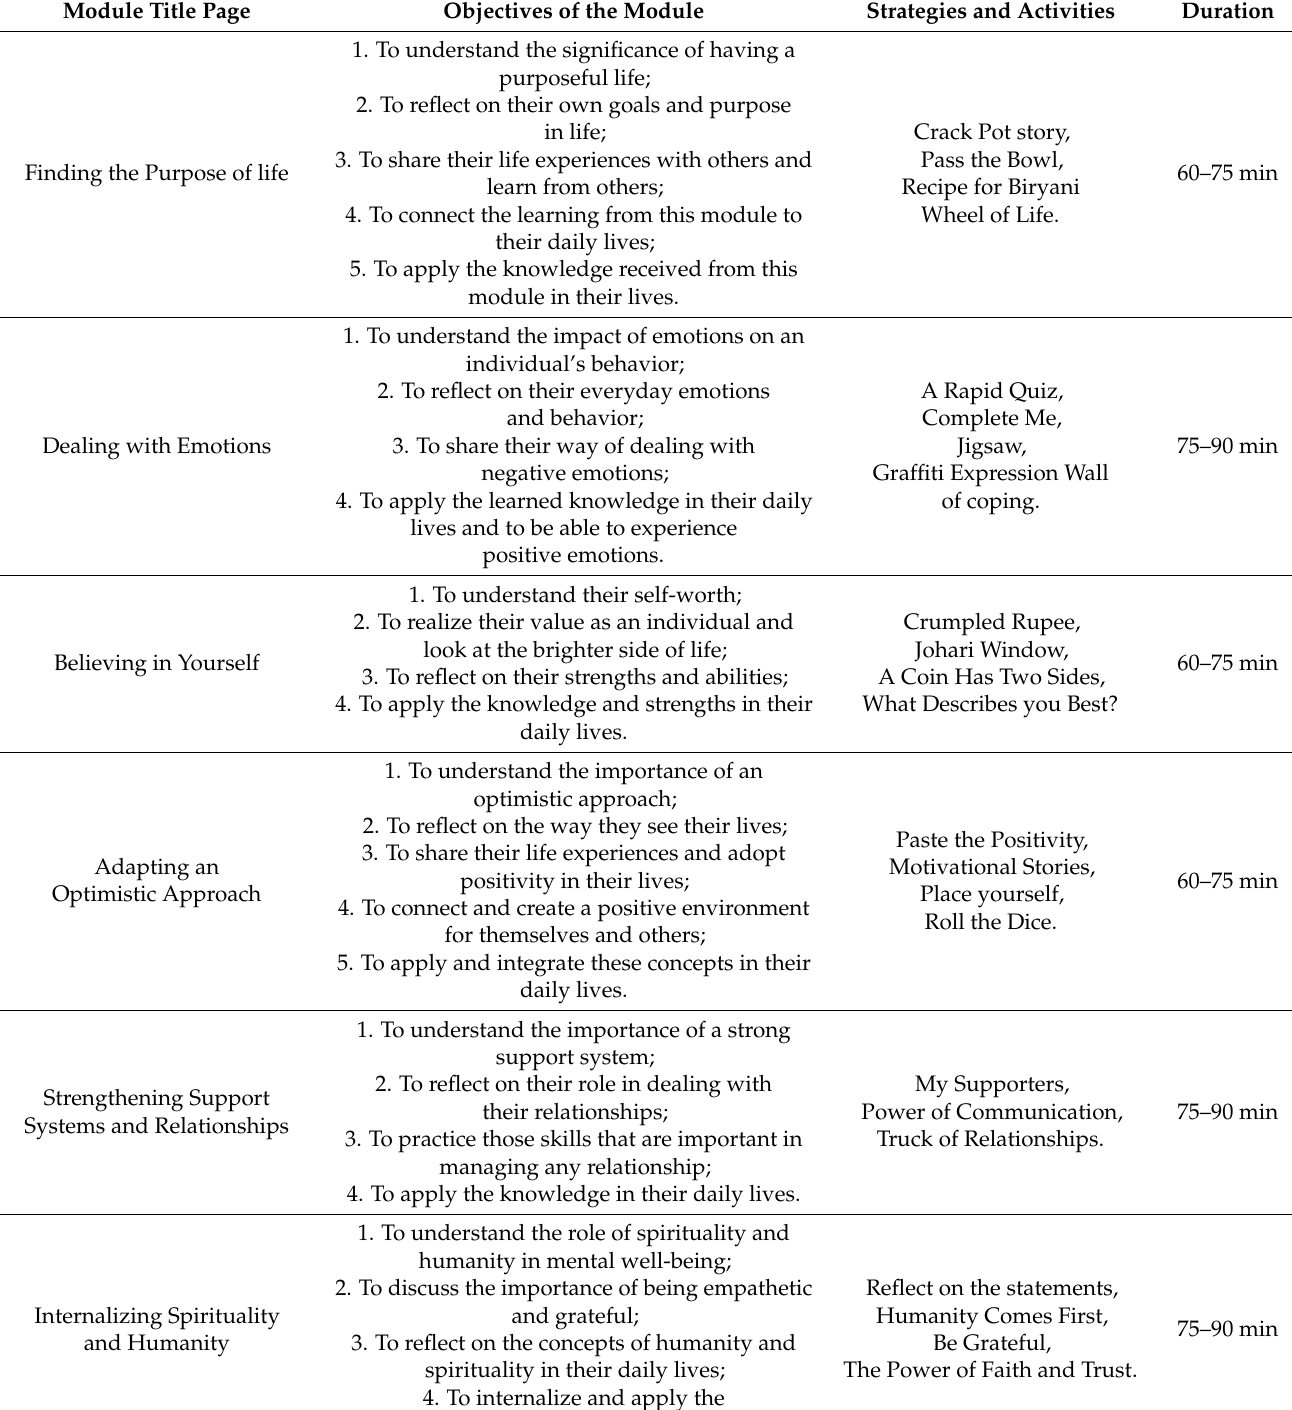
Table 1. SM-ART intervention modules, objectives, strategies, and time